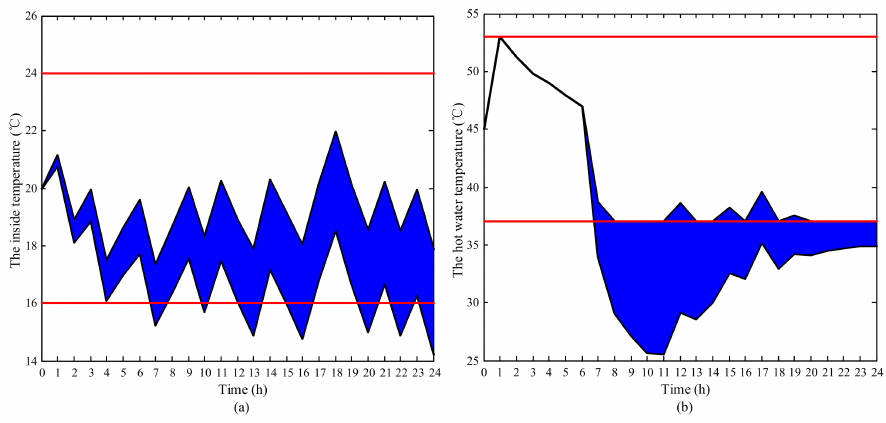
Figure 4. ( a ) The actual temperature set of the air in room; and ( b ) the actual temperature set of the hot water in tank.